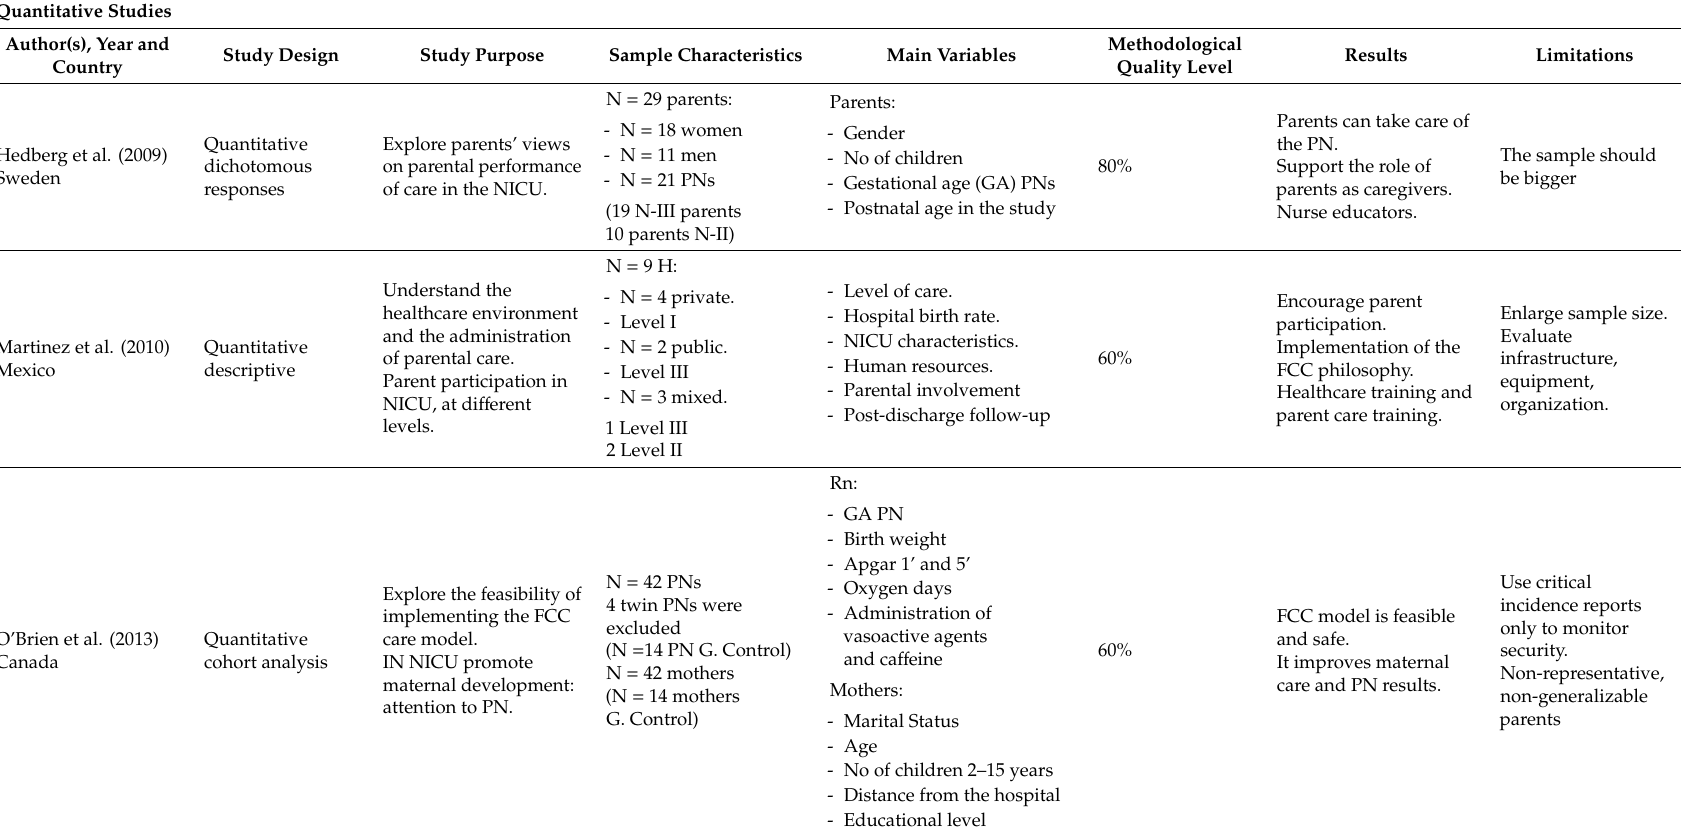
Table 2. Overview of included studies showing active parental involvement in neonatal intensive care unit (NICU) care